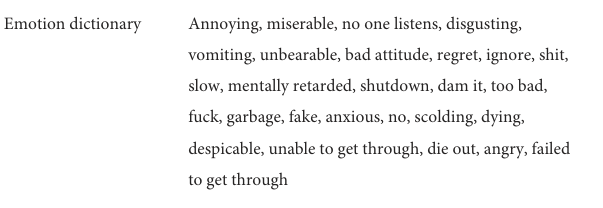
TABLE 1 Emotion dictionary (part).